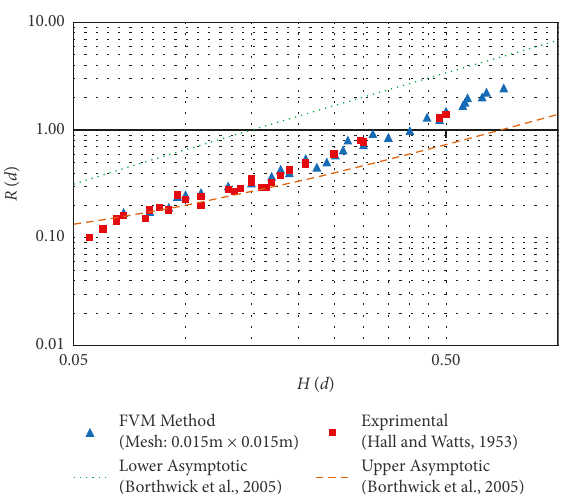
Figure 5: Comparison of model results with experimental work of Hall and Watts [51] for 1:1 sloped